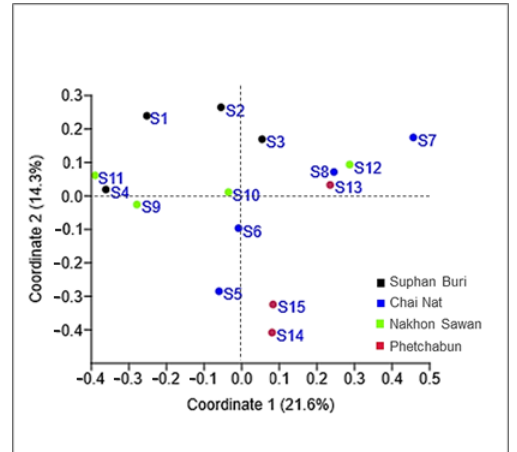
Figure 4. Principal Coordinate Analysis (PCoA) plots of corn phylloplane yeast communities in 15 sampling sites in Thailand, using the Jaccard similarity coefficient.